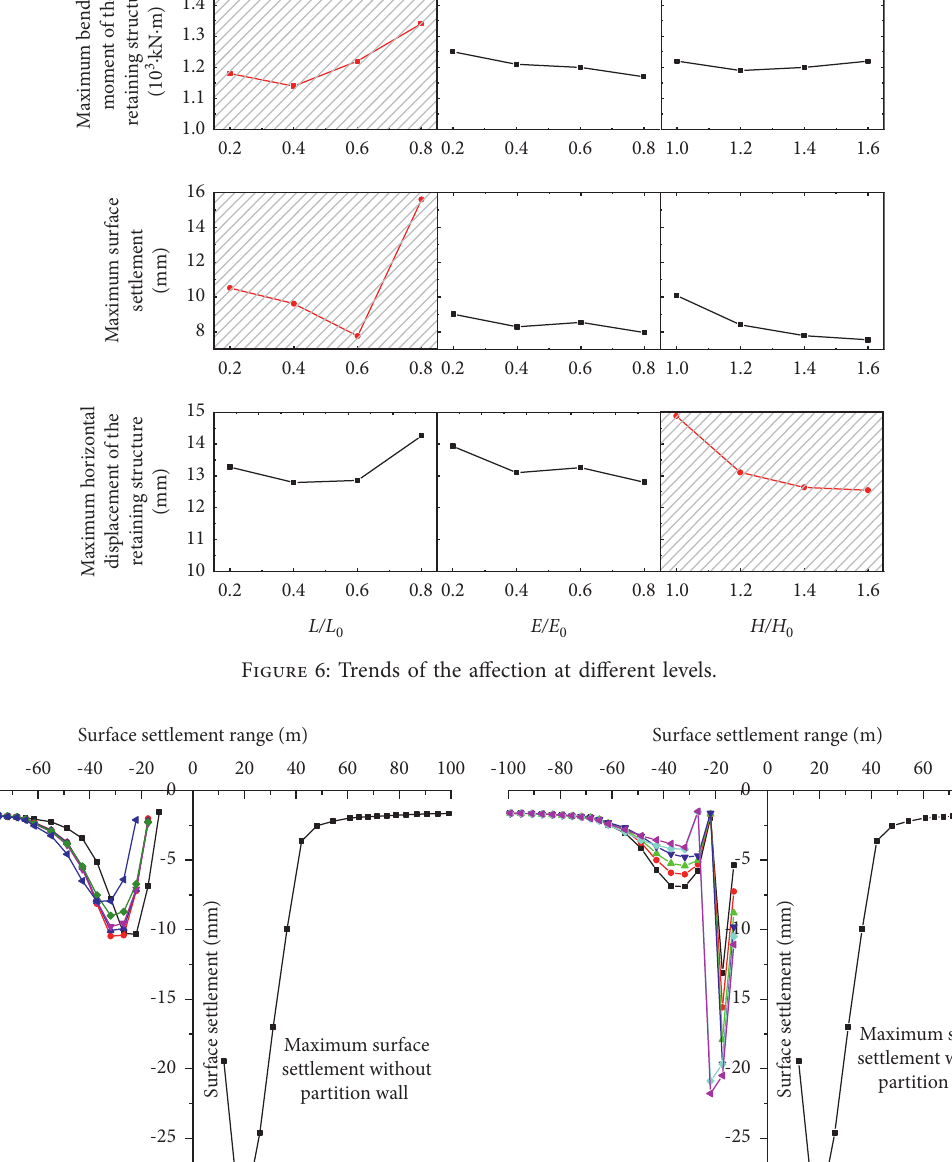
L / L ≤ 0 . 6. (b) L / L > 0 . 0 0